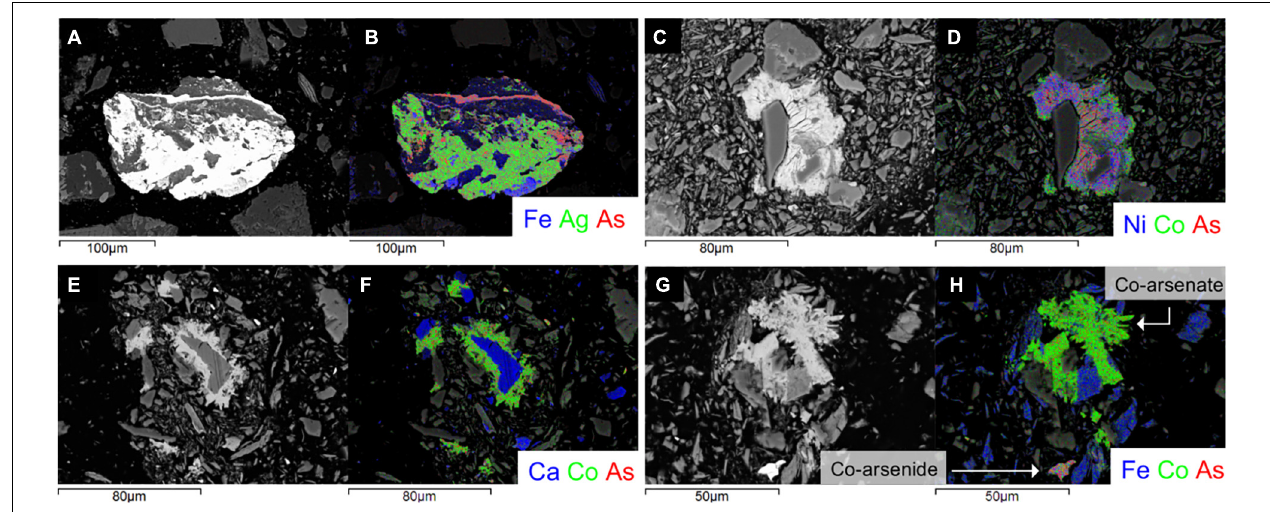
FIGURE 6 | Scanning Electron Microscopy photomicrographs and EDS-chemical maps for representative grains from each tailings site. A silver-sulfide from site A at D = 15 cm (A,B) Ni, Co-arsenate coating on silicates from site B at D = 10 cm (C,D) ; Co-As-bearing grains from site C at D = 20 cm (E-H) : Ni, Co-arsenate coating on carbonates (E,F) , and a Co-arsenate coating on silicates and an Fe, Co-arsenide (G,H) (indicated with an arrow and labeled accordingly).